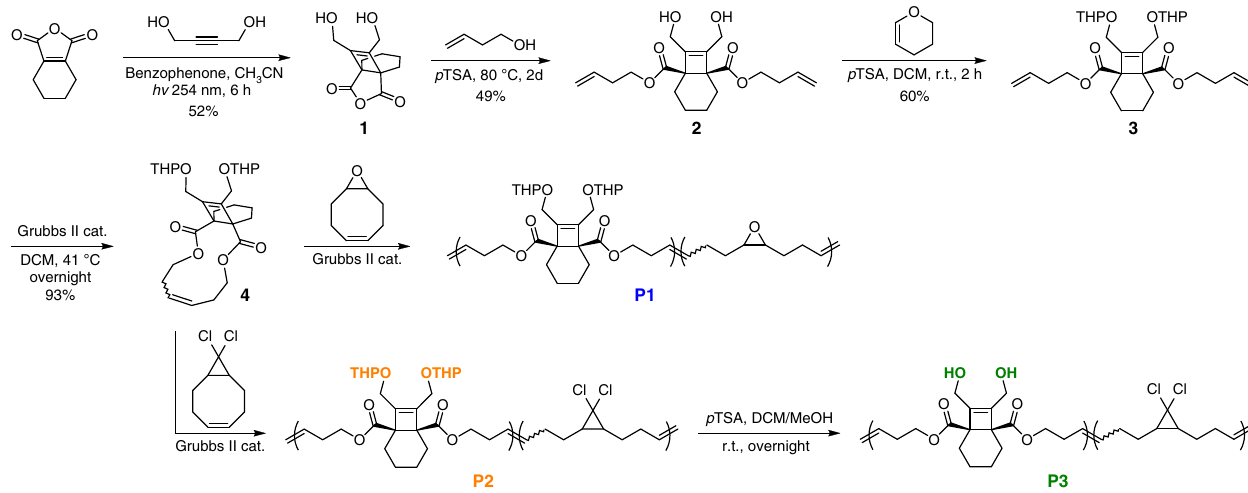
Fig. 3 Synthetic design of BCOE mechanophore and preparation of polymers P1, P2, and P3. p TSA refers to p -toluenesulfonic acid, and DCM is